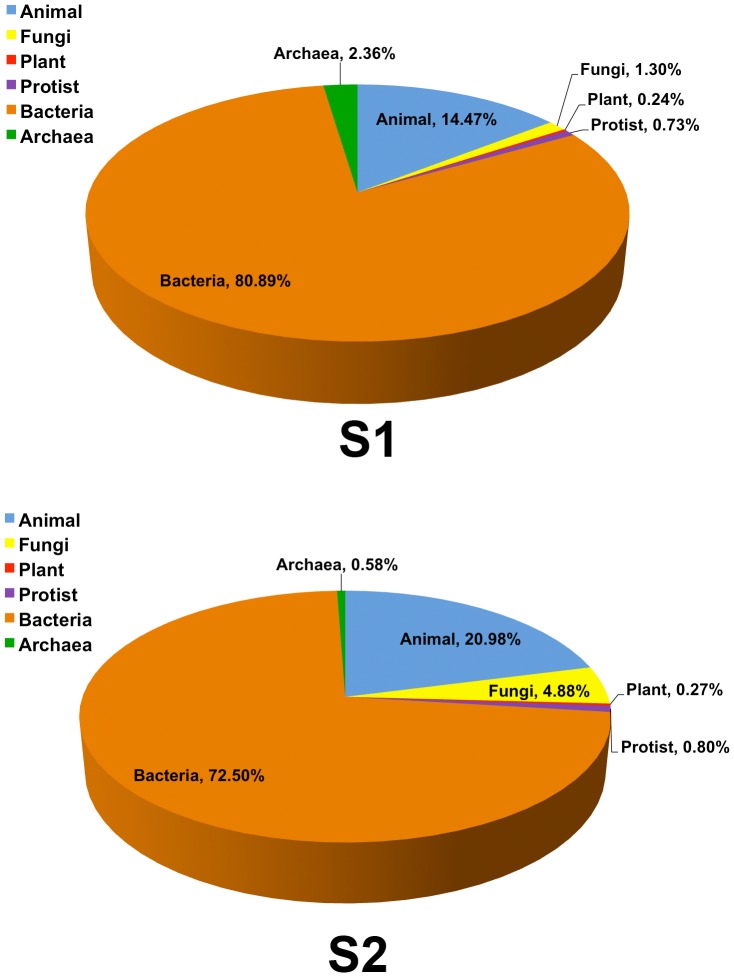
Percentages of 6 kingdoms of lives in S1 and S2.